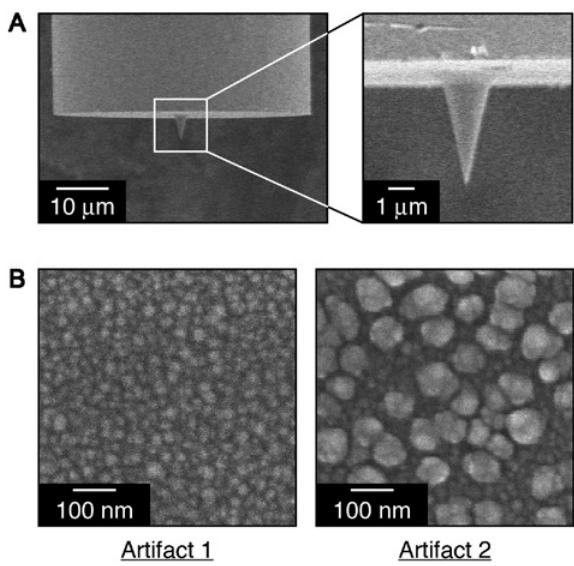
Figure 8: SEM images of the (A) tip of the fiber probe and (B) top views of nanorods in artifacts 1 and 2. Source: Adapted with permis- sion from Springer-Verlag: Appl. Phys. A